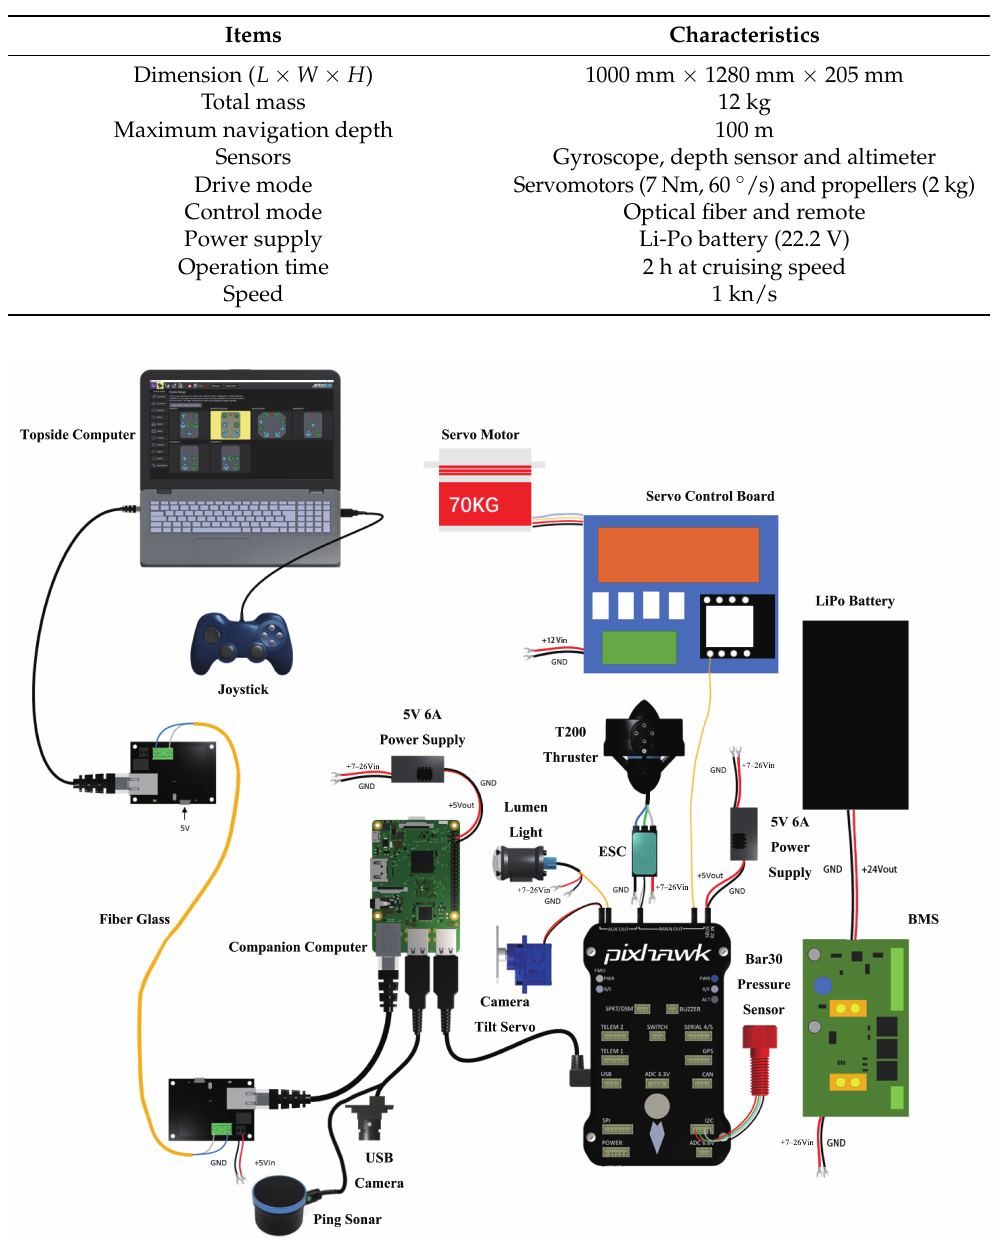
Table 1. The technical parameters of the bionic manta ray robot.